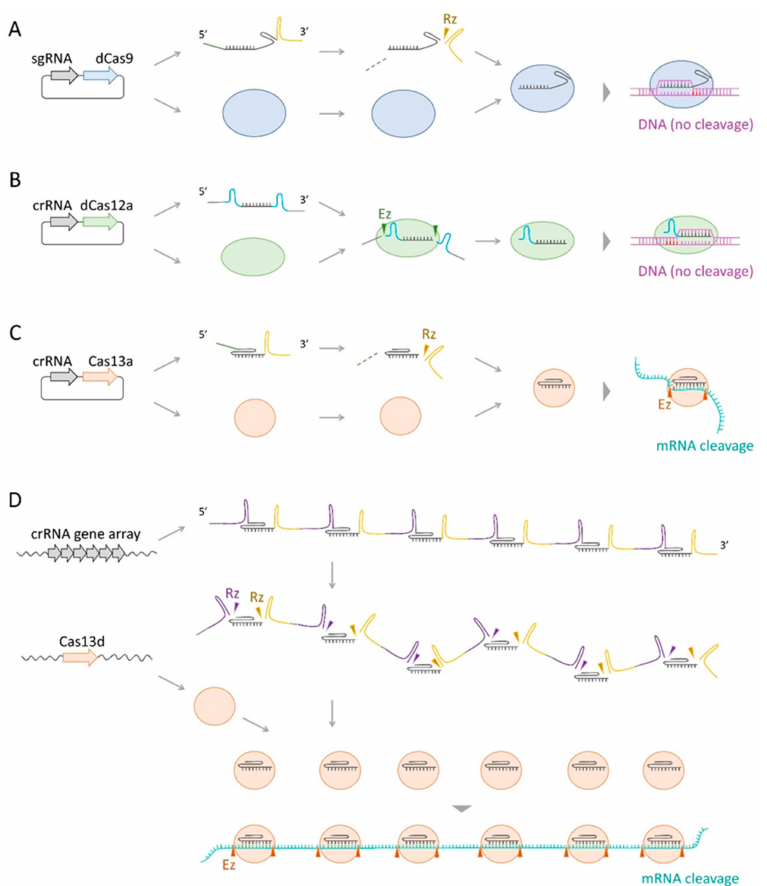
Figure 1. CRISPR–Cas-based gene knockdown technology implemented in S. pombe. ( A ) In dCas9- mediated CRISPRi (Ishikawa et al., 2021 [33]), the sgRNA and dCas9 genes are encoded in an episomal plasmid. The sgRNA precursor is processed by removing the 5 (cid:48) -leader with endogenous nuclease activity (dashed line) and a 3 (cid:48) -ribozyme with self-cleavage activity (Rz, ribozyme activity) to produce a mature sgRNA. The sgRNA–dCas9 complex binds to a specific target DNA where it inhibits transcription without DNA cleavage. The dCas9 gene is regulated by an inducible promoter, while the sgRNA gene is driven by a constitutive rrk1 promoter. ( B ) In dCas12a-mediated CRISPRi (Zhao & Boeke, 2020 [32]), the crRNA and dCas12a genes are encoded in an episomal plasmid. A crRNA precursor is processed by cleaving the 5 (cid:48) -end of direct repeats (light blue) via the nuclease activity of dCas12a (Ez, enzyme activity) to produce a mature crRNA. These cleavages may not be simultaneous. The crRNA–dCas12a complex binds to a specific target DNA where it inhibits transcription without DNA cleavage. Both the cRNA and dCas12a are transcribed by a constitutive RNA polymerase II promoter. ( C ) In Cas13a-mediated gene knockdown (Jing et al., 2018 [35]), the crRNA and Cas13a genes are encoded in an episomal plasmid. The crRNA precursor is processed by removing the 5 (cid:48) -leader with endogenous nuclease activity (dashed line) and a 3 (cid:48) -ribozyme with self-cleavage activity (Rz, ribozyme activity) to produce a mature crRNA. The crRNA–Cas13 complex binds to and cleaves a specific target mRNA (Ez, enzyme activity). The Cas13a gene is controlled by an inducible promoter, while crRNA is driven by a constitutive rrk1 promoter. ( D ) In Cas13d- mediated gene knockdown (Chen et al., 2023 [34]), the crRNA array and dCas13d genes are encoded in plasmids integrated into S. pombe chromosomes. The arrayed crRNA precursor is processed by the self-cleavage activity of two ribozymes adjacent to each crRNA (Rz, ribozyme activity). Each crRNA–Cas13d complex binds and cleaves an mRNA at a specific target region (Ez, enzyme activity). The Cas13d gene is controlled by a constitutive promoter, while the crRNA array gene is driven by an inducible promoter. Length and structure of nucleic acids and proteins presented in this figure do not precisely reflect their molecular